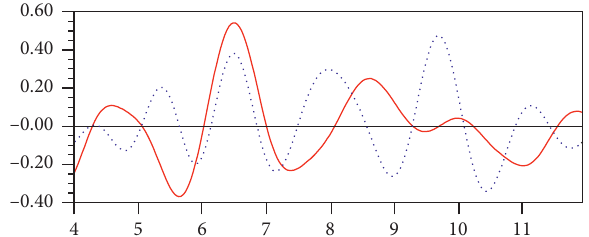
Figure 11: Composite daily ISO index evolution from April to November over the SCS. Red line is in a typical year of the epoch 1979–93, and blue dots are in a typical year of the epoch